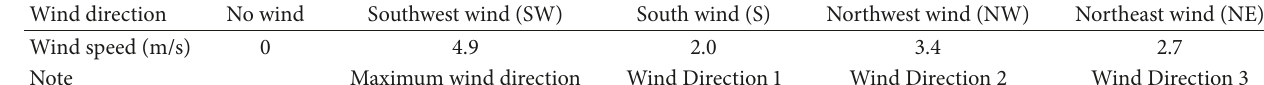
Table 6: Wind conditions of the model.